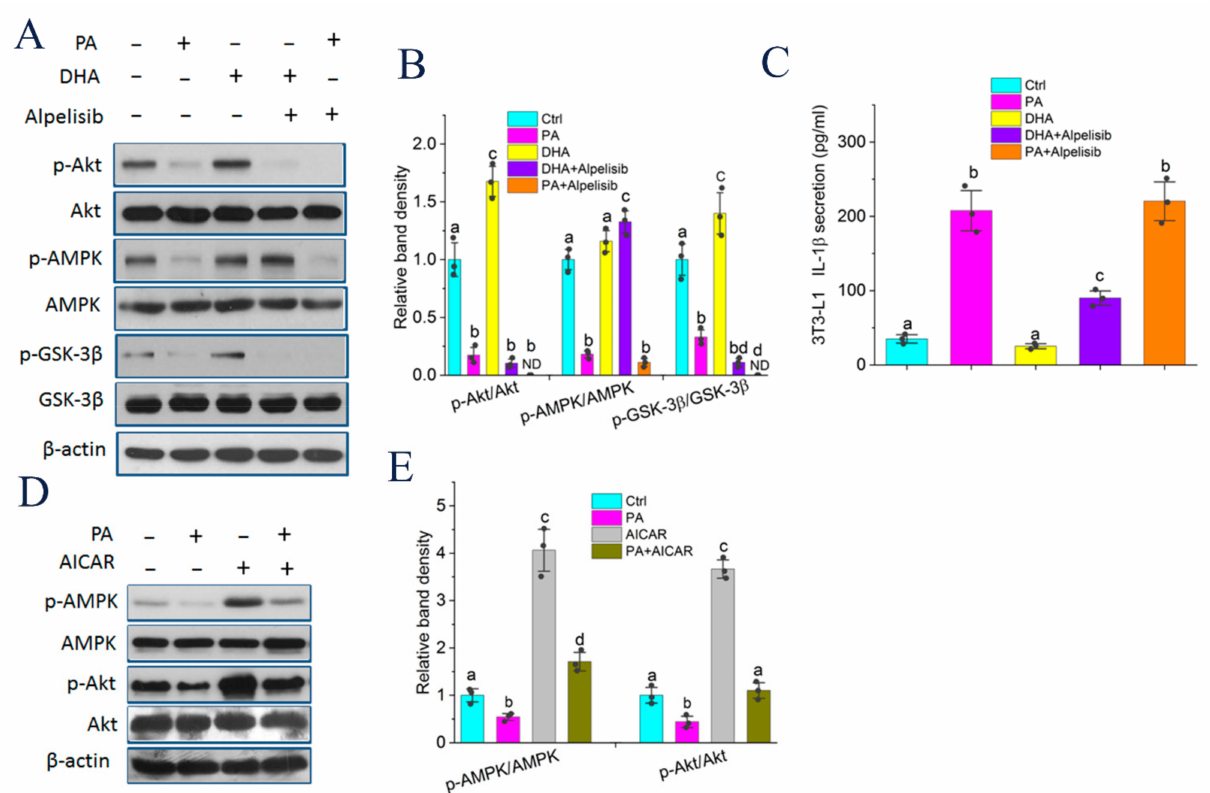
Figure 6. Akt phosphorylation modulated by DHA and AMPK controlled GSK-3 β activity and IL-1 β secretion: ( A ) 3T3-L1 preadipocytes were treated with LPS (10 ng/mL) for 3 h, and then treated with PA (250 µ mol/L), DHA (20 µ mol/L) or Alpelisib (5 nmol/L) for 24 h. Protein lysates were harvested for the analysis of p-Akt, Akt, p-AMPK, AMPK, p-GSK-3 β , and GSK-3 β protein expression; ( B ) Band density analysis of western blotting bands in ( A ); ( C ) The above-mentioned media in ( A ) was used for analysis of IL-1 β secretion by ELISA; ( D ) 3T3-L1 preadipocytes were treated with LPS (10 ng/mL) for 3 h, and then treated with PA (250 µ mol/L) or AICAR (2 mmol/L) for 24 h. Protein lysates were harvested for the analysis of p-Akt, Akt, p-AMPK, and AMPK protein expression; ( E ) Band density analysis of western blotting bands in ( D ). Means not sharing a common superscript letter are significantly different at p < 0.05. ND, not